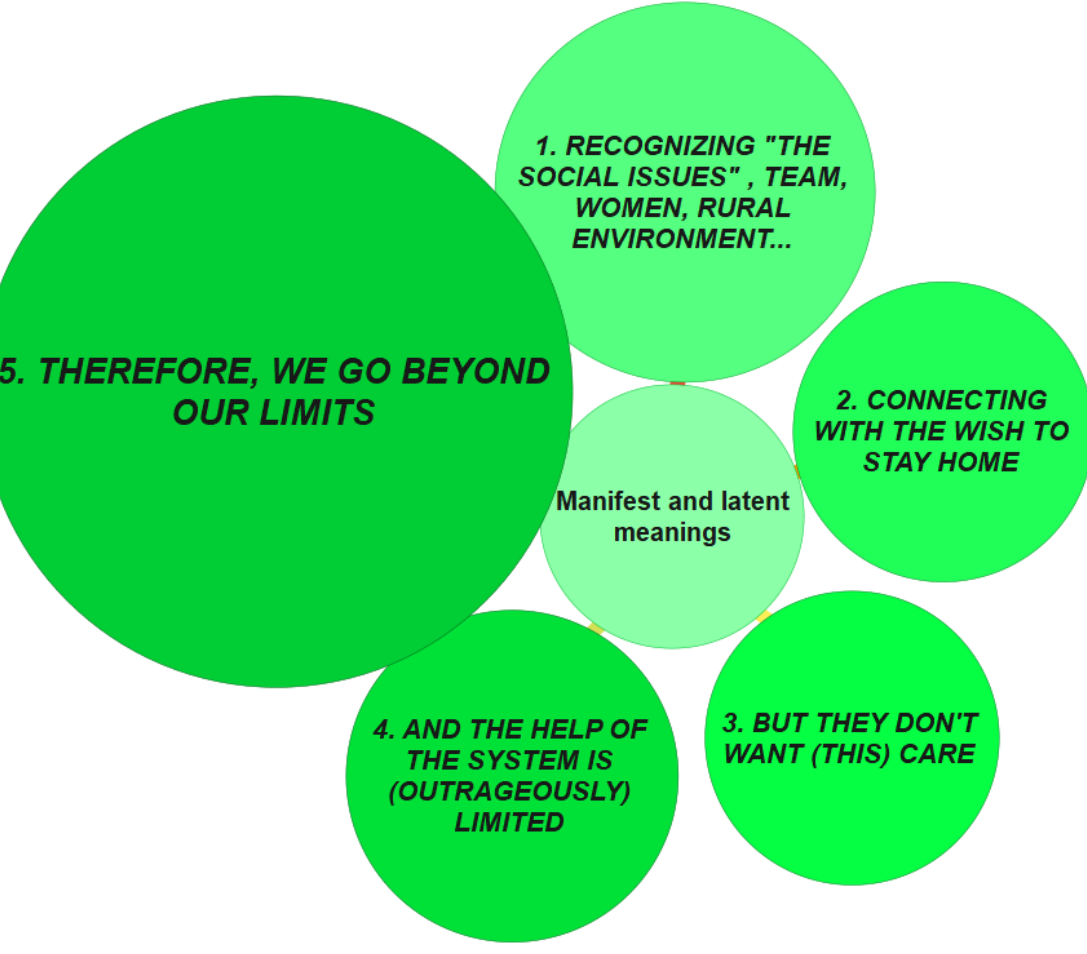
Figure 1. Explanatory framework of results.